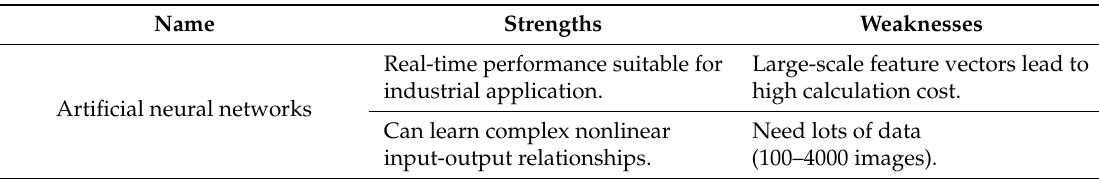
Table 6. Strengths and weaknesses of machine learning-based detection methods for steel